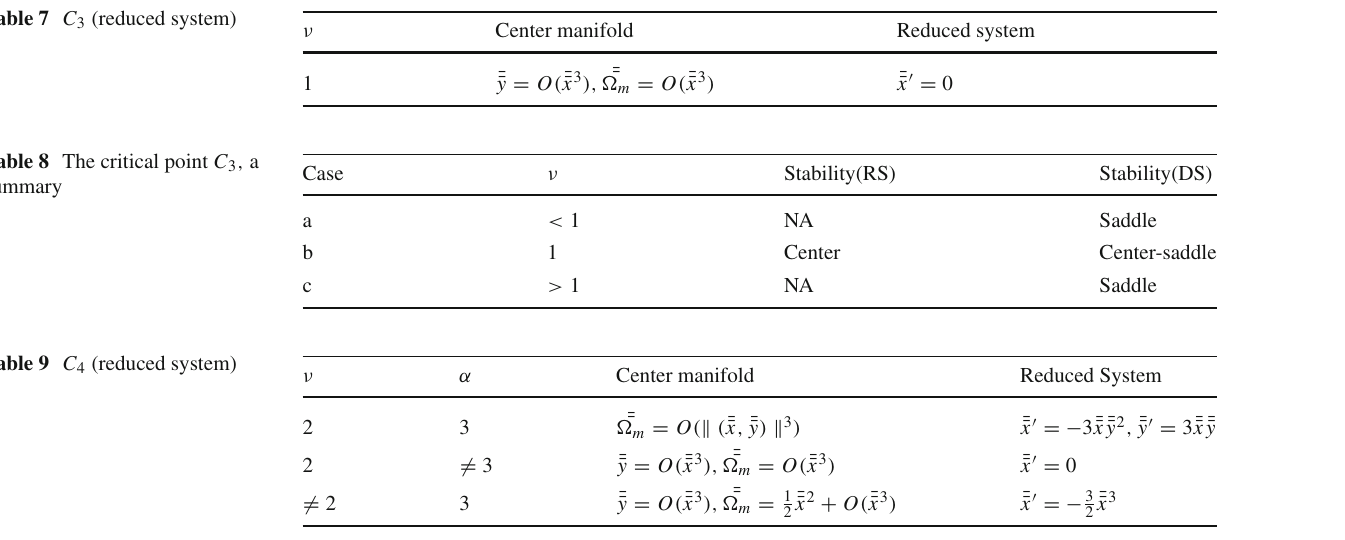
Table 7 C 3 (reduced system)